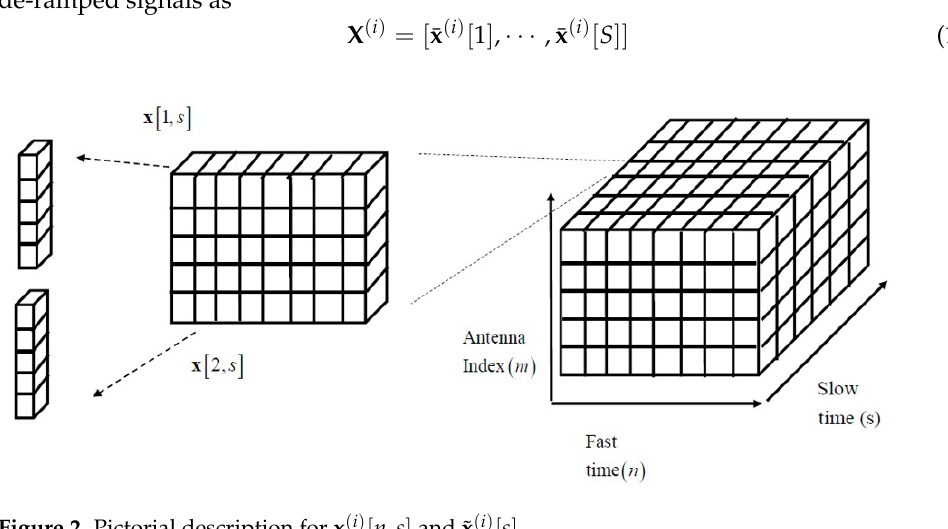
Figure 2. Pictorial description for x ( i ) [ n , s ] and ˜ x ( i ) [ s ]